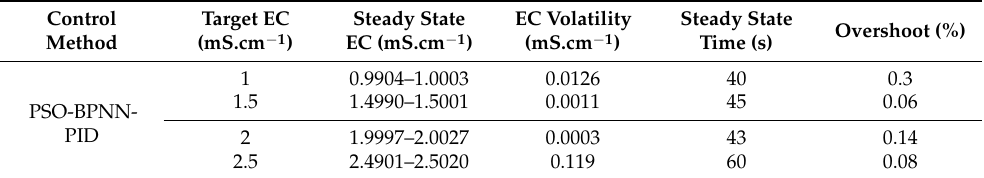
Table 5. Control parameters and performance indicators for different EC values.